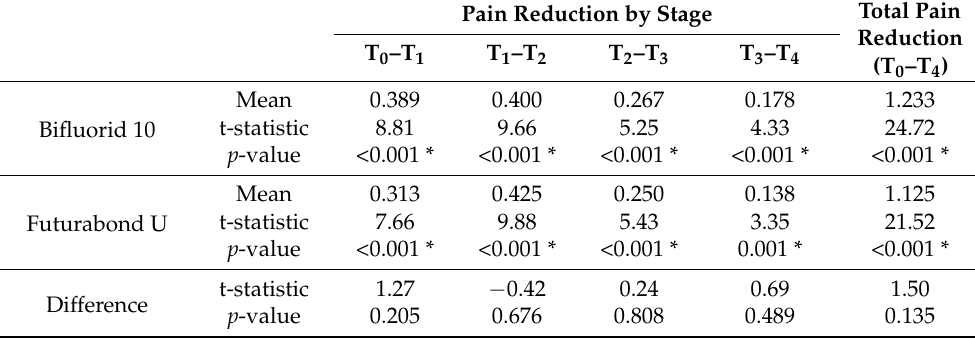
Table 1. Significance of pain reduction at four stages and total pain reduction in Bifluorid 10 and Futurabond U groups and difference between groups accordingly to Schiff measurements. Positive value of t-statistic in “Difference” row indicates larger efficacy of Bifluorid 10, negative values of Futurabond U.